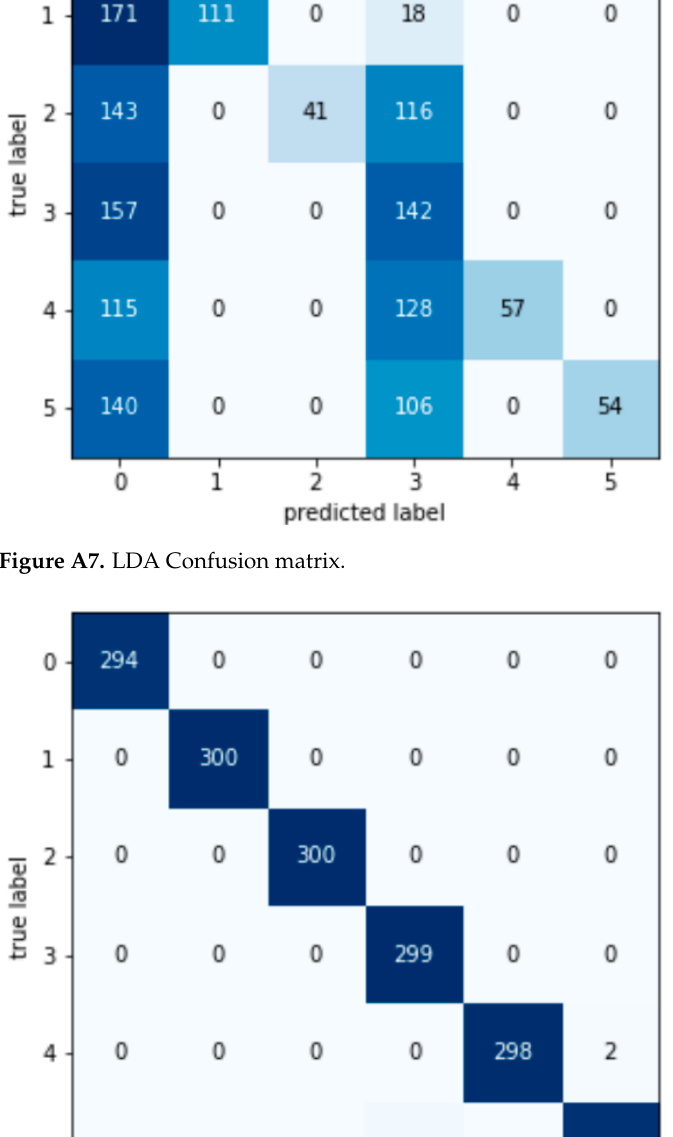
19 of 23 Figure A6. Bayesian confusion matrix. According to the test set confusion matrix of various machine learning models shown in Figures A1–A8, it is not difficult to find that the number of false detections in the ran-